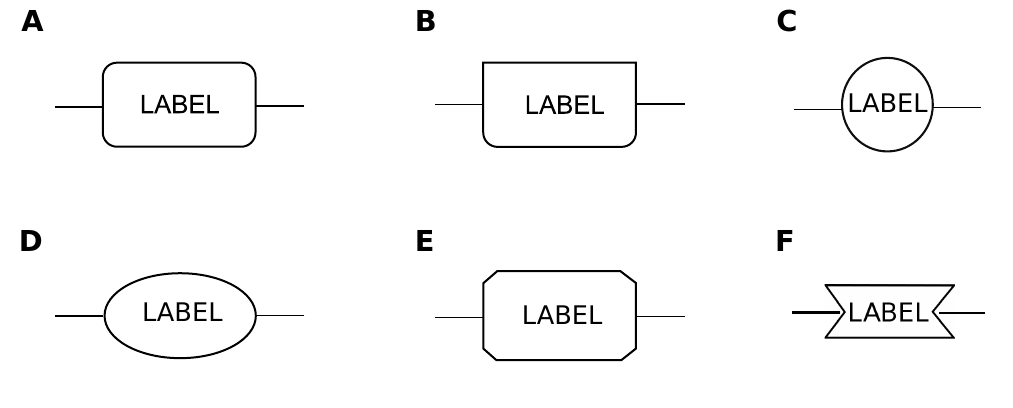
Figure 2.5: The Activity Flow glyph for unit of information .